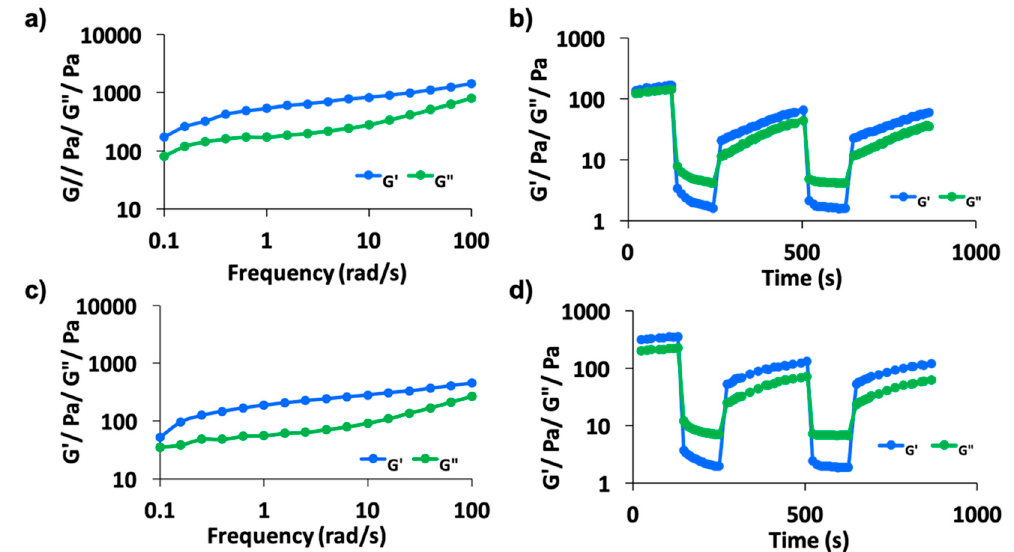
Figure 2. ( a ) Frequency sweep experiments on MA- L -Phe-OH. G’ (storage modulus) remains higher than G” (loss modulus). ( b ) Step strain experiments of MA- L -Phe-OH. Cycle 1 under 0.1% straight and G’ remains higher than G”, cycle 2 under 100% strain gel is reverted to the sol phase where G” is higher than G’, cycle 3 lifts the strain and is back to 0.1% and is back in gel phase as G’ is greater than G”. This is repeated for two more cycles to show self-healing properties of the gel. ( c ) Frequency sweep experiments on MA- D -Phe-OH. G’ (storage modulus) remains higher than G” (loss modulus). ( d ) Step strain experiments of MA- D -Phe-OH. Cycle 1 under 0.1% strain and G’ remains higher than G”, cycle 2 under 100% strain gel is reverted to the sol phase where G” is higher than G’, cycle 3 lifts the strain and is back to 0.1% and is back in gel phase as G’ is greater than G”. This is repeated for two more cycles to show self-healing properties of the gel.